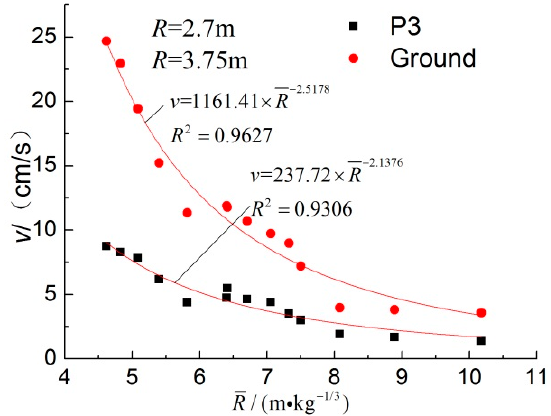
Figure 14. The attenuation curves of PPVV and GPPV.